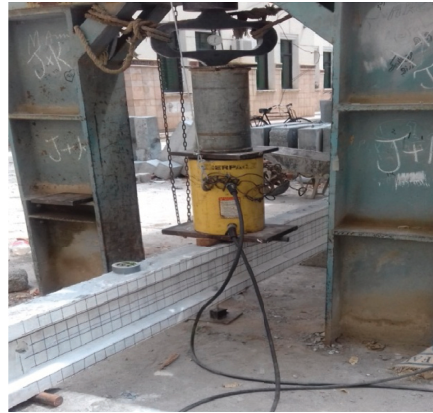
Figure 3: Actual test setup using centre point loading.